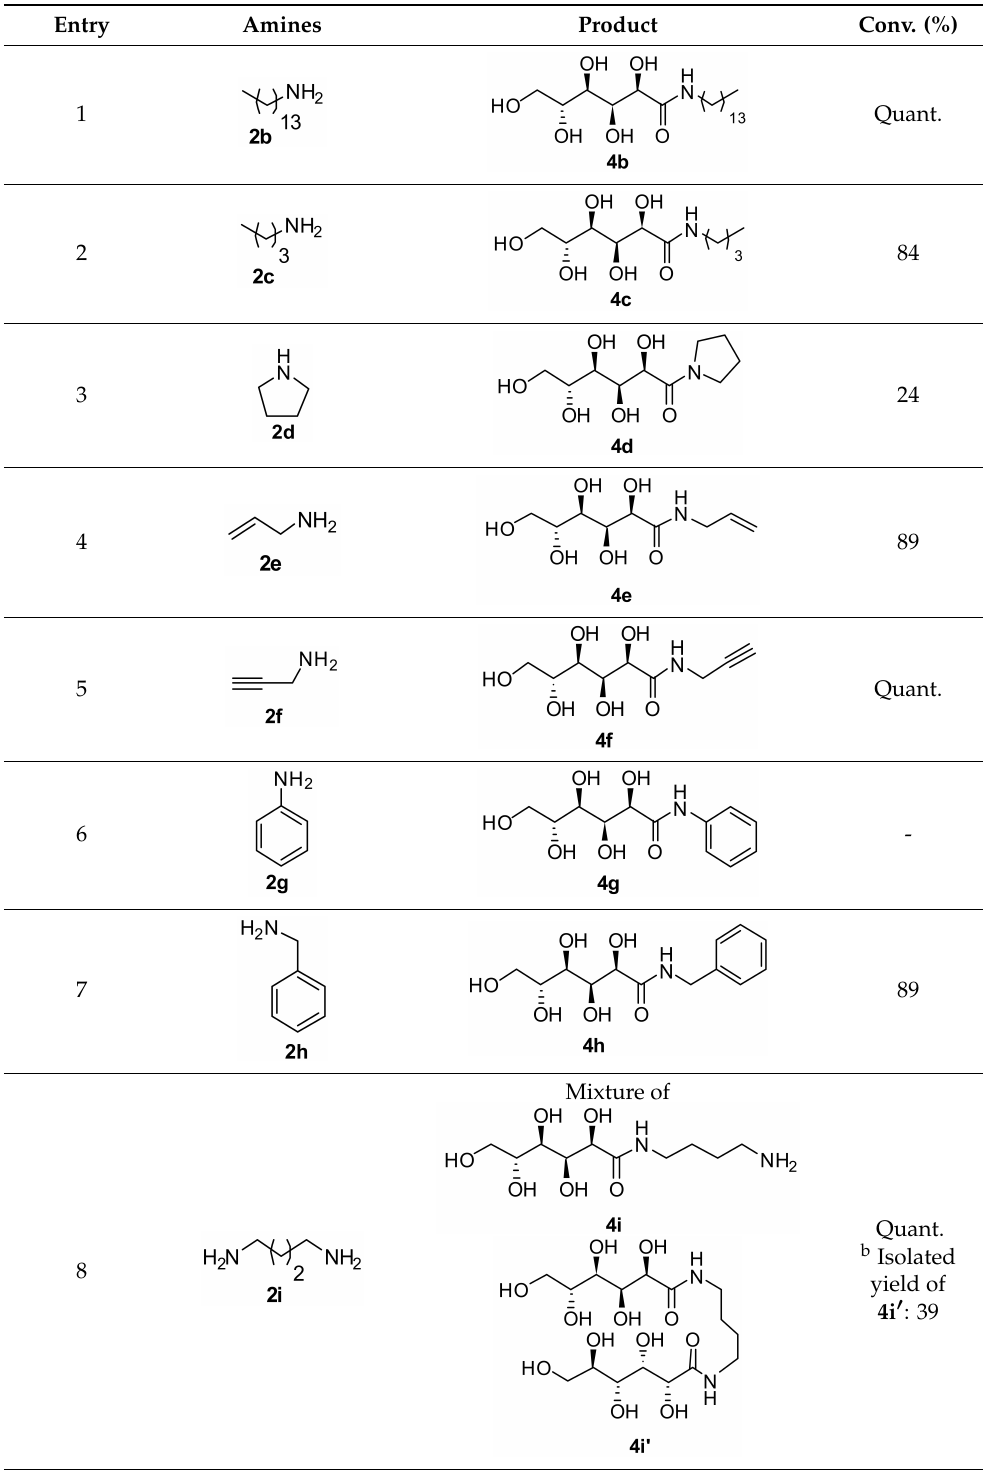
Table 4. Applications to various amines a